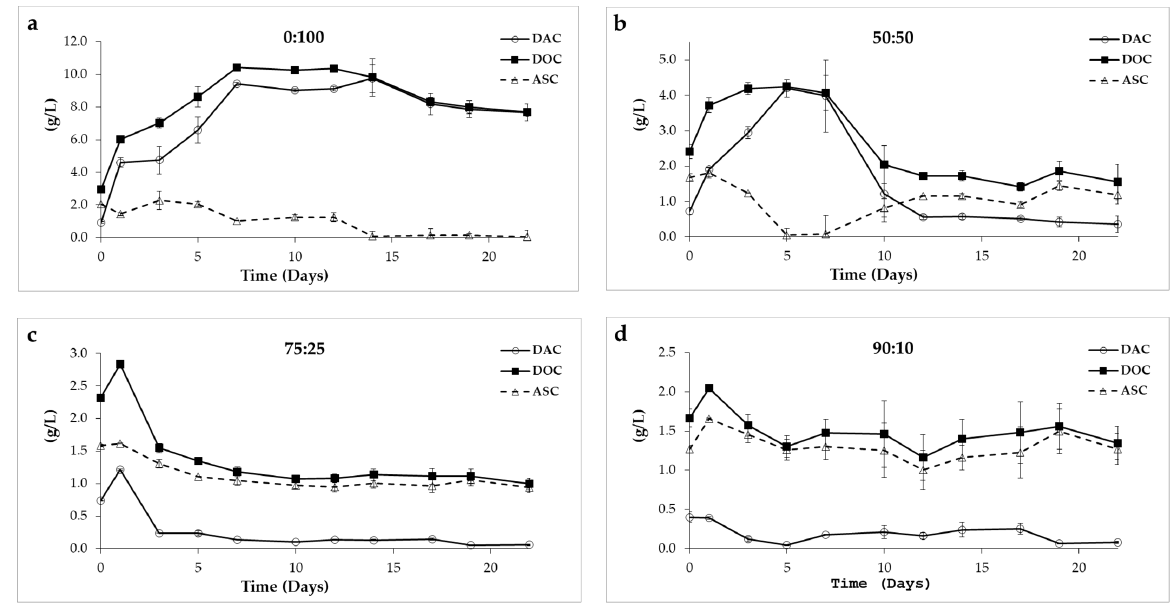
Figure 8. Evolution of dissolved acid carbon (DAC), dissolved organic carbon (DOC), and carbon as acid substrate (ASC) parameters. ( a ): 0:100 mixture ratio; ( b ): 50:50 mixture ratio; ( c ): 75:25 mixture ratio; ( d ): 90:10 mixture ratio.